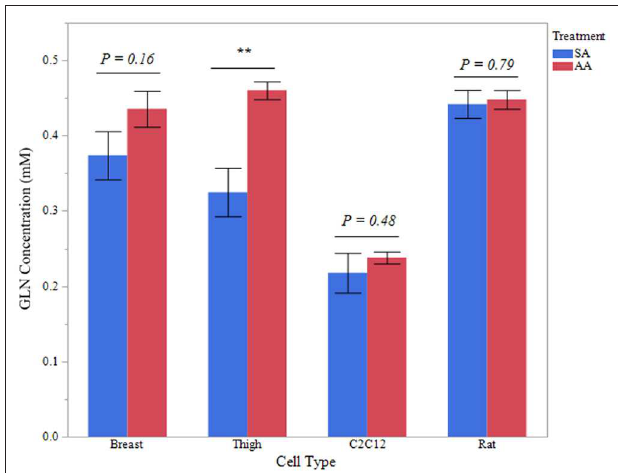
FIGURE 6 | Intracellular glutamine concentration. Glutamine concentration of total protein isolated from primary breast, primary thigh, C2C12, and primary rat myotube cultures treated with sodium acetate (10mM) or ammonium acetate (10mM) for 24h ( n = 6 independent samples). Asterisk represent significant differences between treatments for each cell type (** P < 0.01).